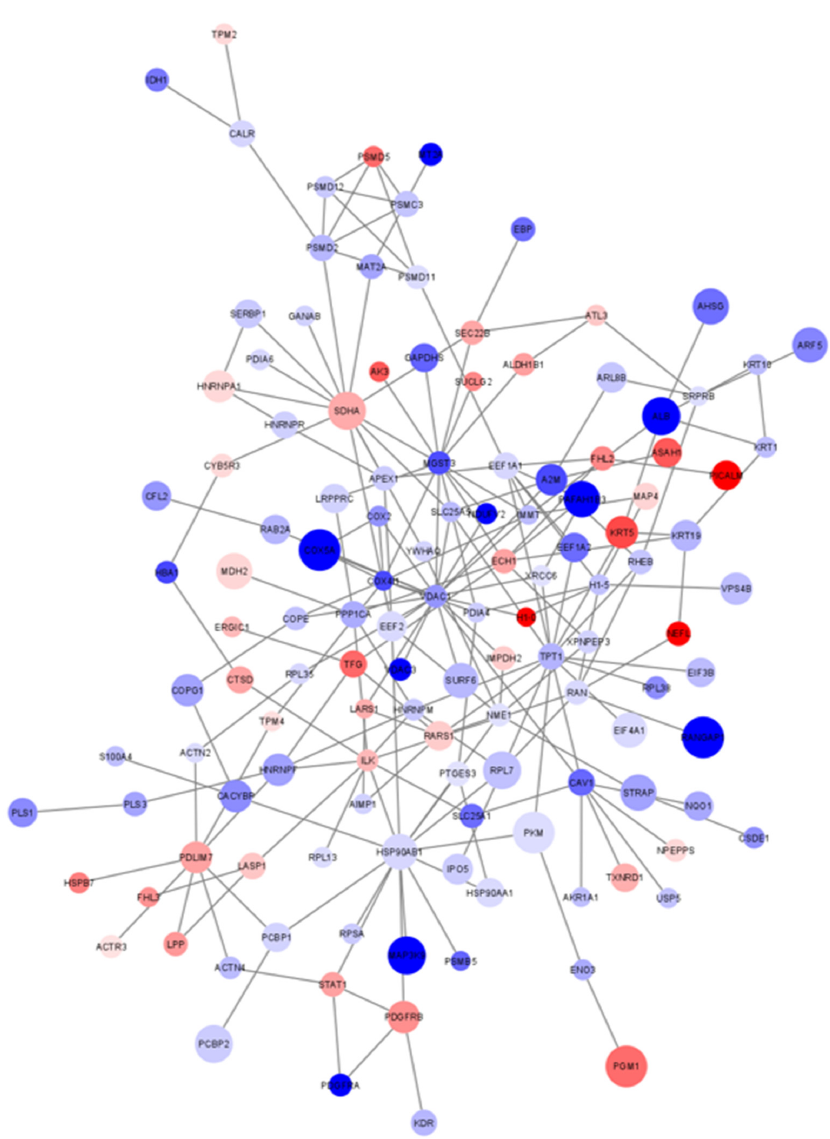
Figure 5. Main component of the PPI network of differentially expressed proteins. Each node represents one protein ( n = 129). Node color is associated with the FC. Blue: proteins downregulated in ALS_C9 vs. ALS_N; red: proteins upregulated in ALS_C9 vs. ALS_N. Node size is proportional to the − log 10 (adjusted p value): the larger the size, the lower the protein-associated p value.